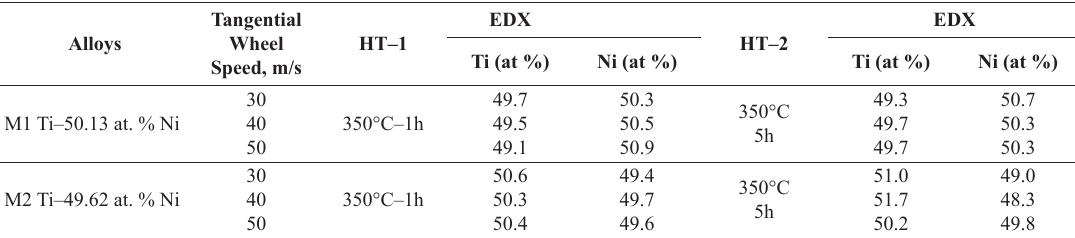
Table 2. Thermal and chemical characteristics of the obtained ribbons Alloys